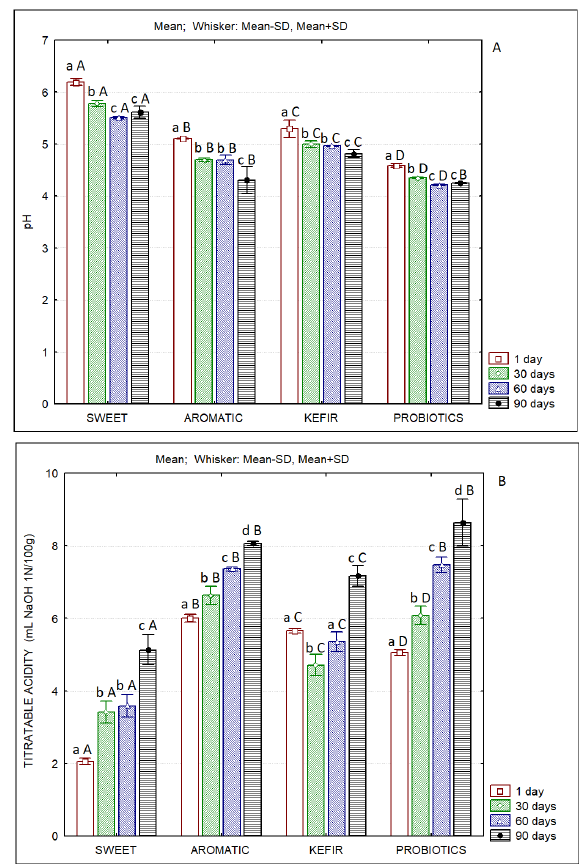
Figure 1. Evolution of pH and titratable acidity of sheep’s butters produced with sweet cream and with cream fermented with different starter cultures. Different lowercase letters (a,b,c,d) indicate significant differences ( p < 0.05) between days of storage; Different capital letters (A,B,C,D) indicate significant differences ( p < 0.05) between products at the same storage day.